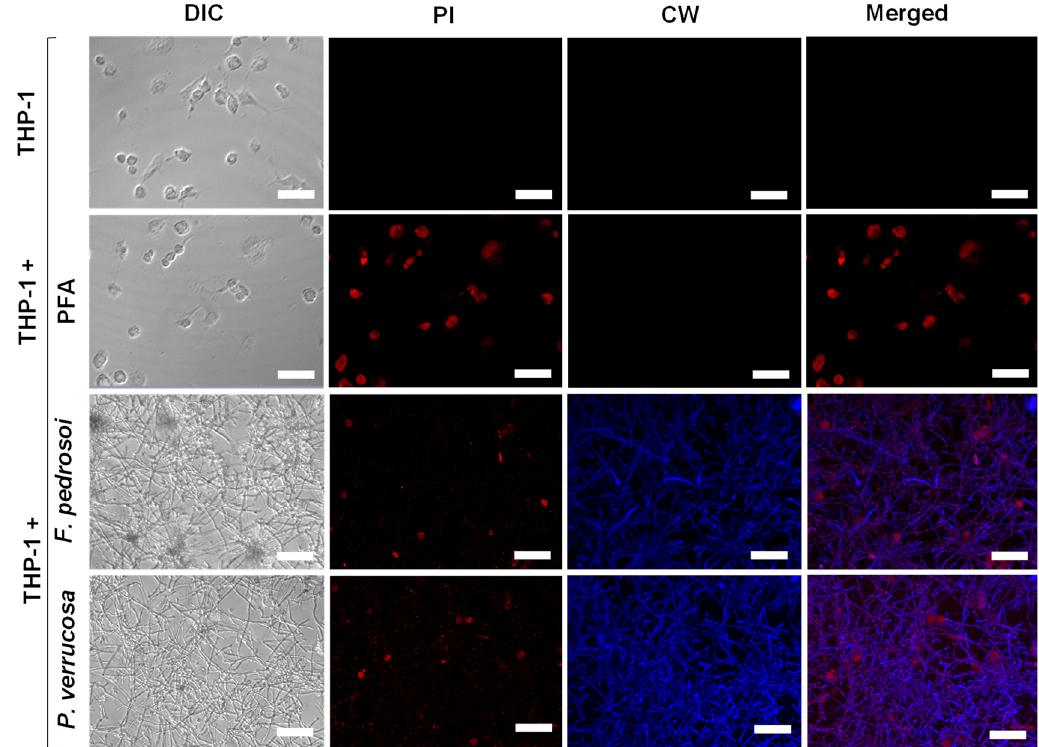
Figure 7. Confocal microscopy of fungal biofilm formation on THP-1 cells. The human monocytic leukemia cell line (4 × 10 5 /mL) was added in 24-well cell culture plates containing RPMI medium supplemented with 80nM PMA to differentiate macrophage cells, as detailed in Material and Methods. Representative images of THP-1 cells non-treated (control of viable cells), treated with paraformaldehyde (PFA, control of non-viable cells) or incubated for 48 h with (4 × 10 6 /mL) of F. pedrosoi and P. verrucosa . After co-culturing, the systems were washed with RPMI and incubated with propidium iodide (PI) and calcofluor white (CW). THP-1 cells damage by fungal biofilm formation was monitored using confocal differential interference contrast (DIC) and fluorescence microscopy. Bars, 50 µm.